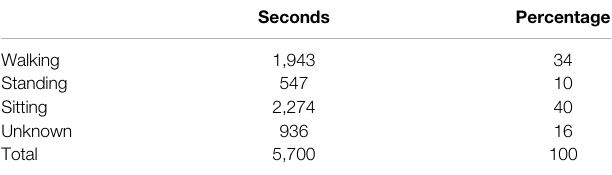
TABLE 1 | Discrimination by video camera.